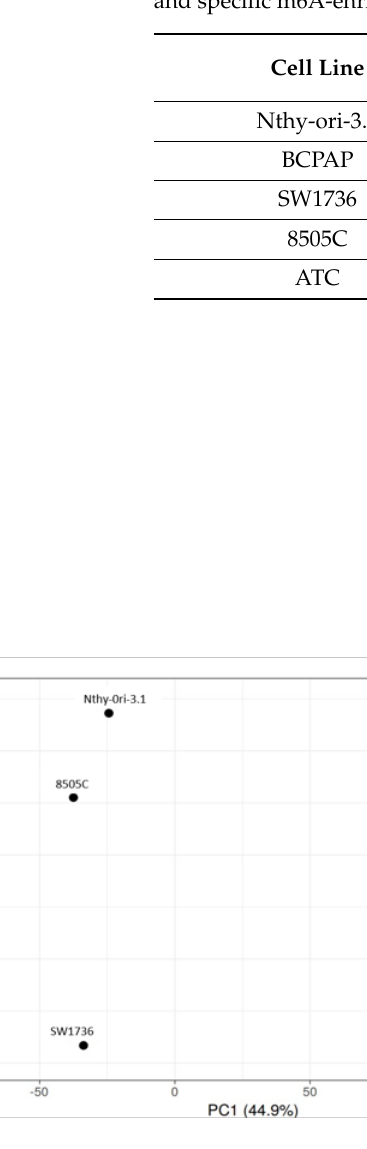
Table 1. Numbers of total and cancer-specific mRNAs containing m6A (total m6A-enriched mRNAs and specific m6A-enriched mRNAs, respectively).